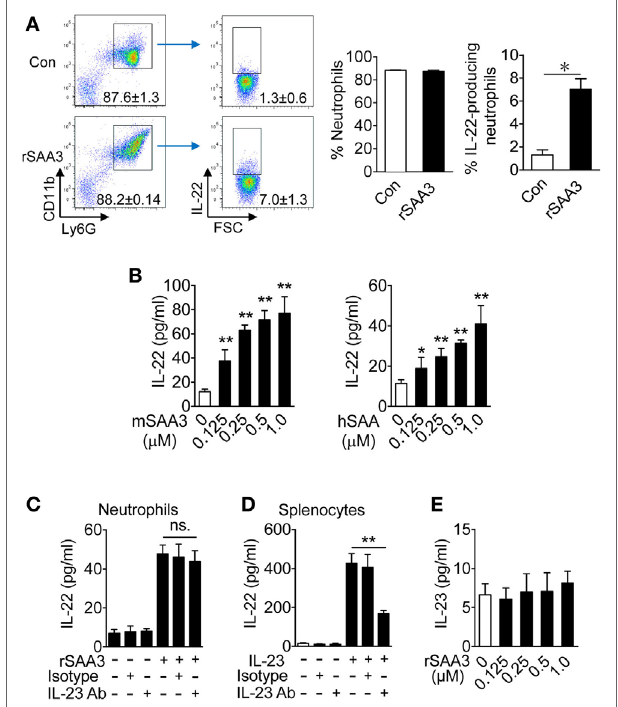
FigUre 6 | Serum amyloid A (SAA)3 induces neutrophil expression of IL-22. Neutrophils from bone marrow of wild-type C57BL/6 mice (both male and female, 8–10 weeks of age) were treated with recombinant SAA3 (rSAA3) (1 µM) or PBS (Con) for 24 h before analysis. (a) Representative flow cytometry dot plots showing the effects of rSAA3 on the CD11b + Ly6G high neutrophil population (left two panels) and IL-22-producing neutrophils (right two panels). Quantification data, based on five mice in each group, are shown in bar charts on the right. * p < 0.05. (B) Bone marrow neutrophils were treated with mouse rSAA3 (mSAA3, left) or human rSAA1 (hSAA, right) for 24 h. IL-22 release was quantified by ELISA. Bone marrow neutrophils (c) or splenocytes (D) were incubated with an anti-IL-23 antibody (1 µg/ml) or IgG isotype control (Isotype) for 1 h before adding rSAA3 (1 µM) for 24 h. The culture medium was collected and IL-22 concentration was determined by ELISA. Splenocytes (right) from the same mice were pre-incubated with the IL-23 Ab or IgG isotype control for 1 h before stimulation with 20 ng/ml of IL-23 for 24 h. IL-22 release was measured by ELISA. (e) IL-23 production by neutrophils stimulated with indicated concentrations of rSAA3 for 24 h. All quantitative data shown are mean ± standard margin of error based on triplicate measurement, using neutrophils from three to five mice. * p < 0.05, ** p < 0.01 between different samples